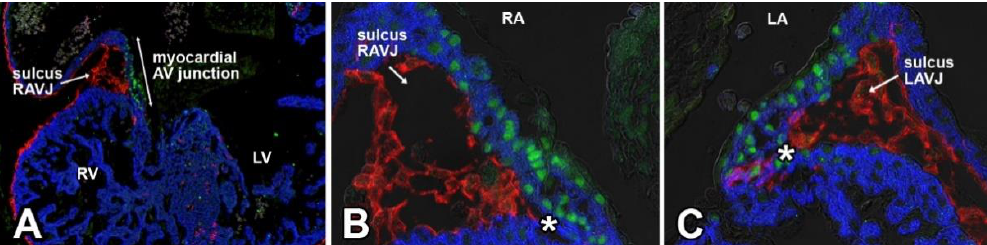
Figure 3. Epicardially-derived cells in the AV sulcus at ED12. EGFP-labeled AV-EPDCs (pseudo-colored in red) are providing the mesenchyme of the AV sulcus. Staining for the transcription factor TBX3 (green) delineates the AV-junctional myocardium ( A – C ). As demonstrated in ( A – C ), the AV-EPDCs penetrate the myocardial wall (blue) at the lower boundary of the AV-junctional myocardium. ( B is a higher magnification of A ).